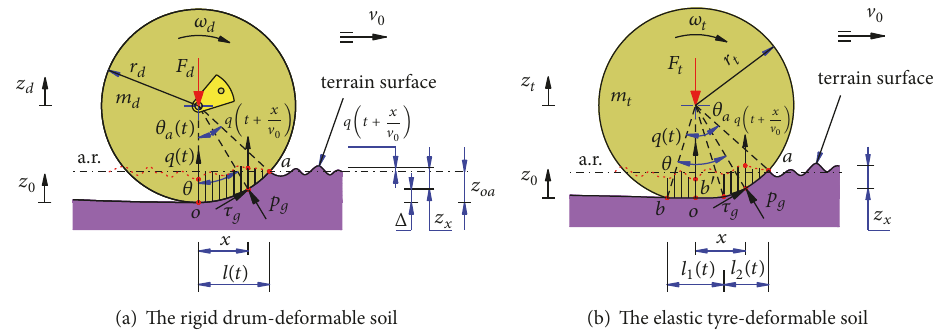
Figure 4: The wheels-soil interaction models